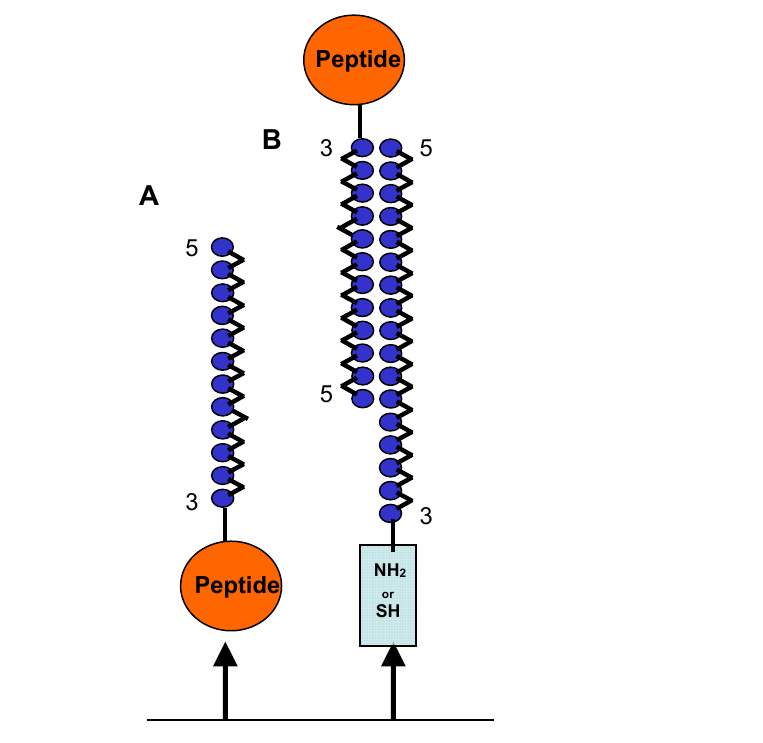
Figure 6. Schematic representation of two forms of OPC binding. A) Single OPC attached to ELISA plate and B) duplex OPC formed by OPCs and their complementary strand, which is attached to the ELISA plate through a thiol or an amino